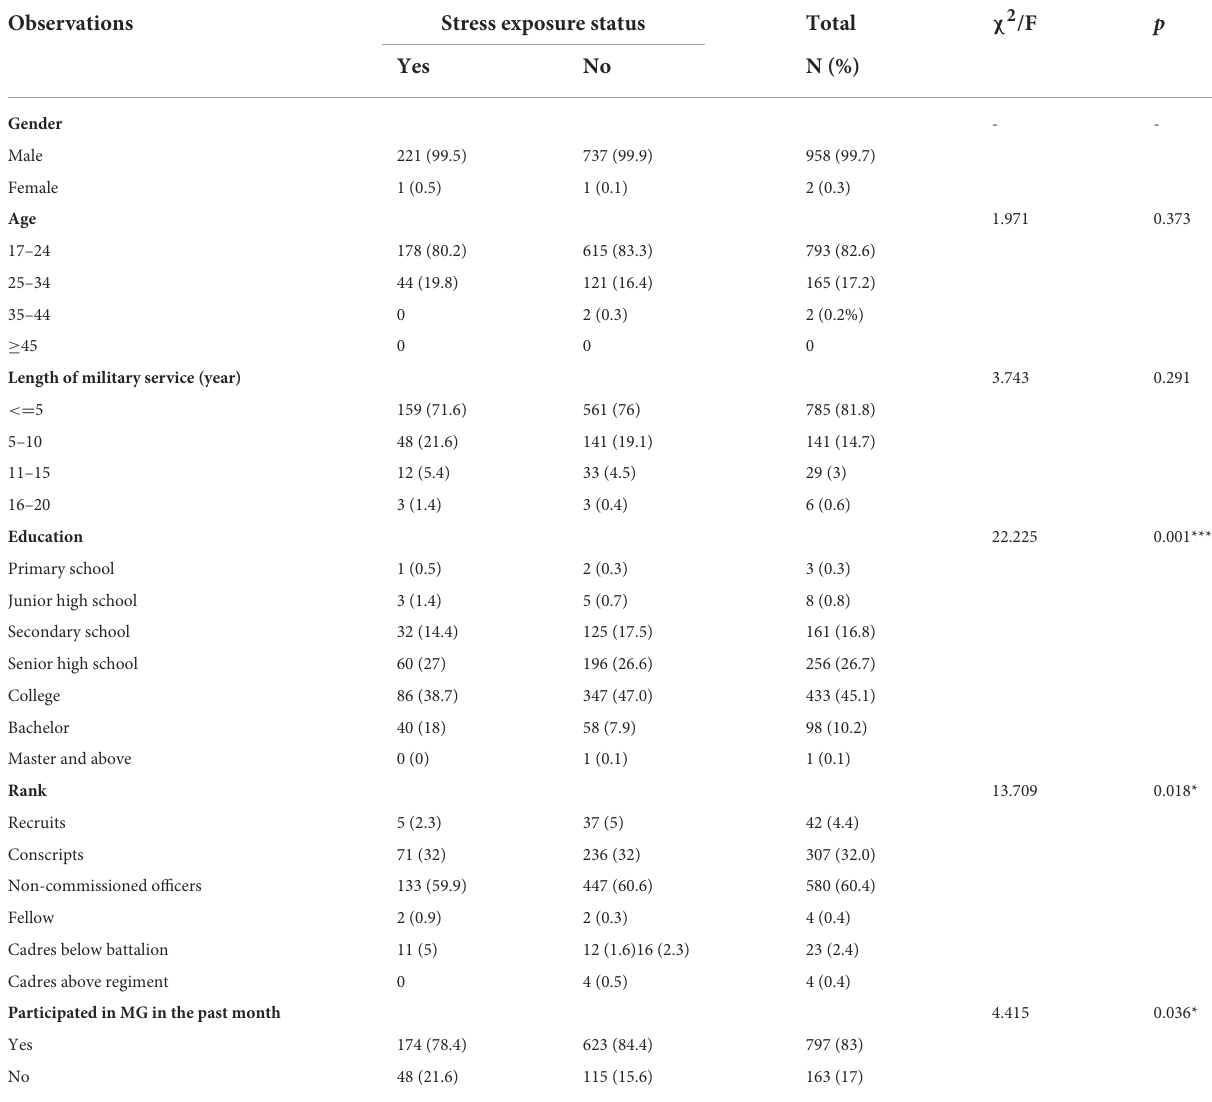
TABLE 1 Sociodemographic characteristics of PAP